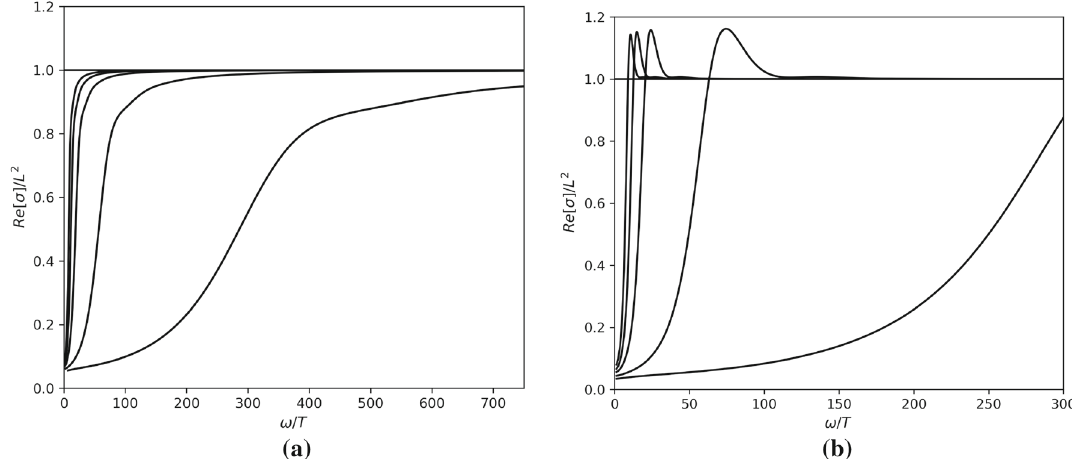
Fig. 9 The evolution of Re σ (ω) versus ω/ T at ε = 16 π, L = 2 for O 1 ( a ) and O 2 ( b ). Each graph, from left to right, is plotted for the cases T / T c = 0.7, 0.5, 0.3, 0.1 and 0.02